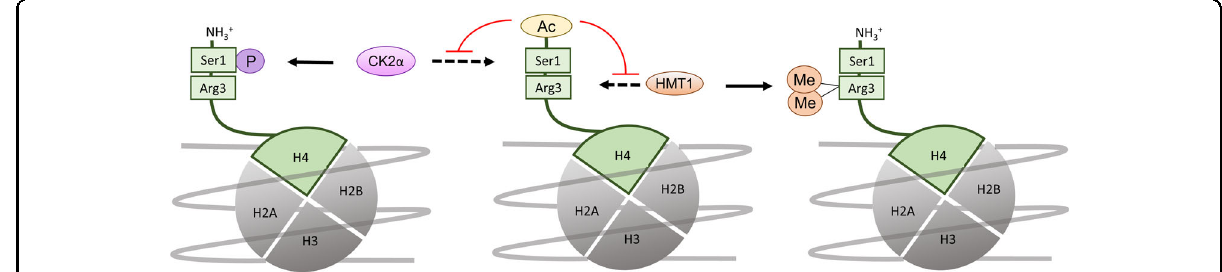
Fig. 4 Crosstalk between Nt-acetylation and other modi fi cations near the histone H4 N-terminus. Nt-acetylation of histone H4 precludes other modi fi cations near the N-terminus. Nt-acetylation of H4 blocks the nuclear translocation of casein kinase 2, α subunit (CK2 α ) and phosphorylation of Ser1 on H4. Arg3 dimethylation of yeast H4 by histone methyltransferase 1 (HMT1) is also precluded by H4